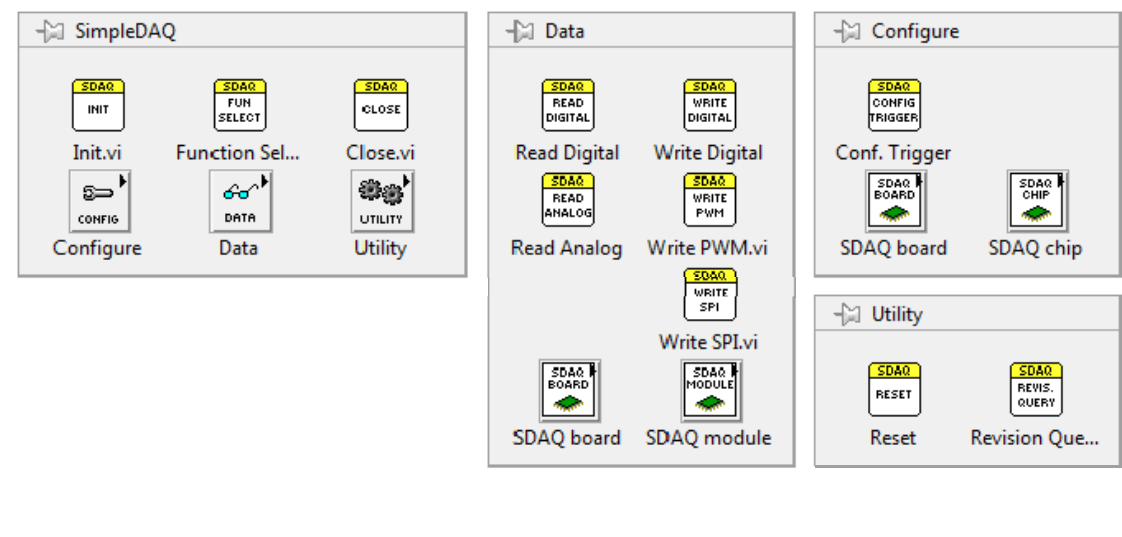
Figure 10. SimpleDAQ palette in